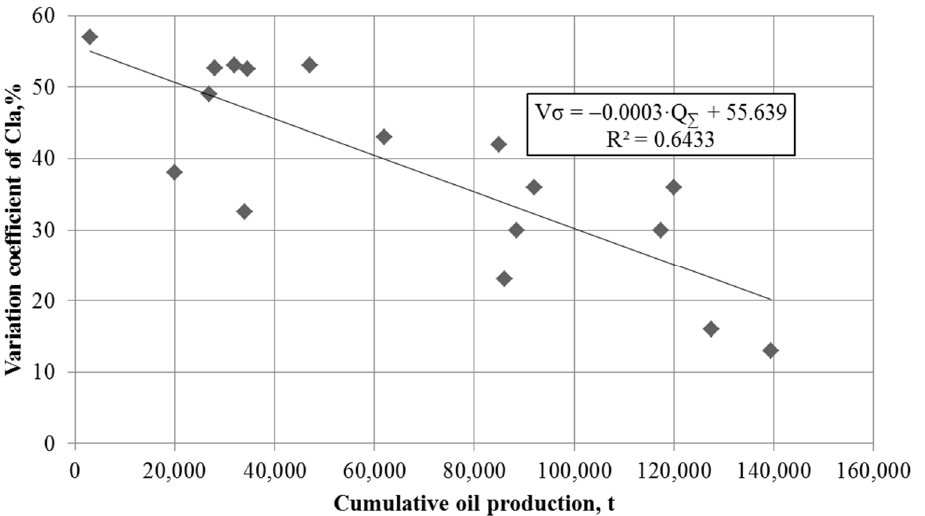
Figure 1. Variation coefficient of coefficient of light absorbance vs cumulative oil production [96].